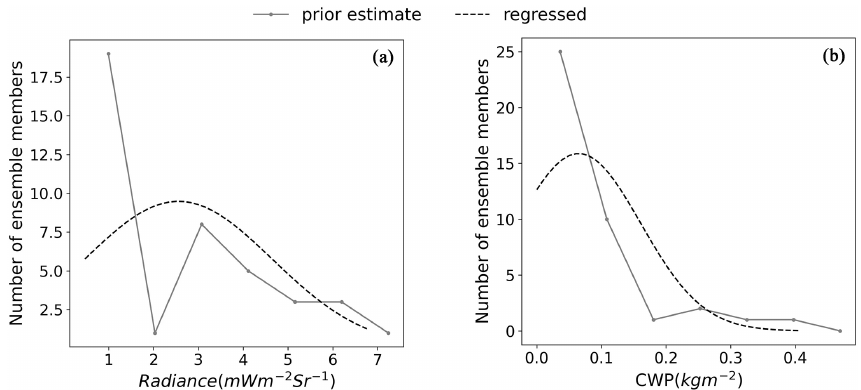
Figure 6. The first-guess probability density functions (PDFs) of (a) equivalent visible radiance and (b) the cloud water path (CWP). The PDFs were estimated from the 40 prior ensembles for point 3 (red dot) in Fig.